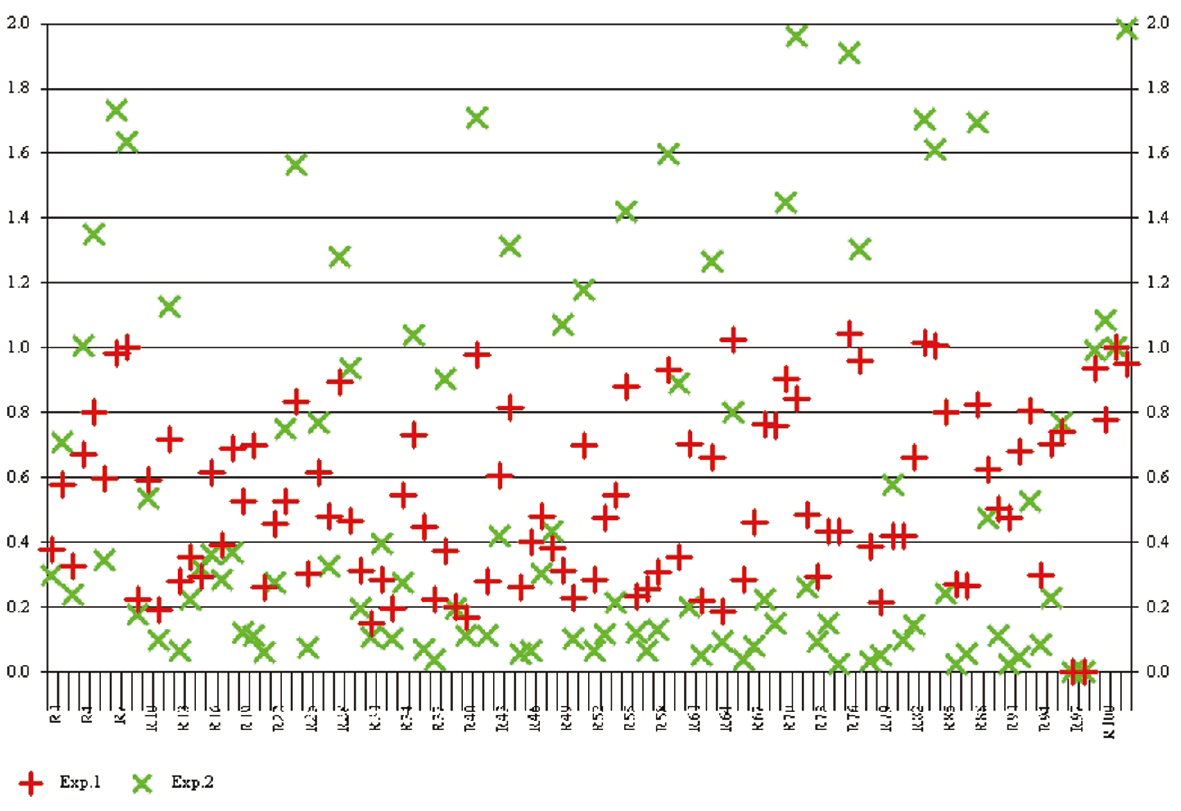
Figure 2 The differential gene expression between the positive control and Sal B treated OSCC . The crosses show the magnitude of differential expression between the positive control and Sal B treated OSCC. Red = the positive control; Green = Sal B treated